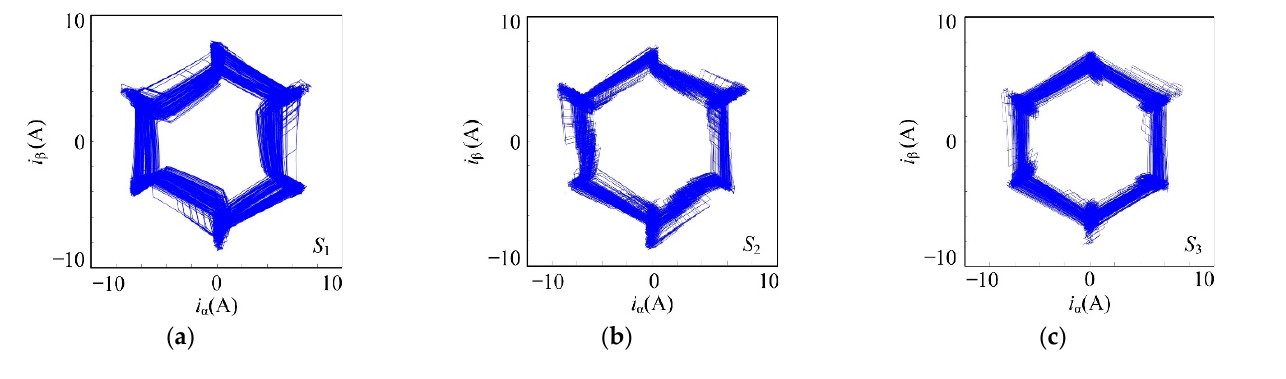
Figure 17. ( a ) Current vector trajectory diagram of S 1 ; ( b ) Current vector trajectory diagram of S 2 ; ( c ) Current vector trajectory diagram of S 3 .